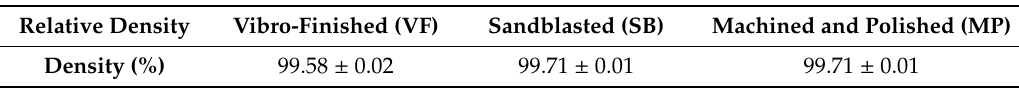
Table 2. Relative density of the investigated AlSi10Mg specimens processed by L-PBF after various surface finishes.